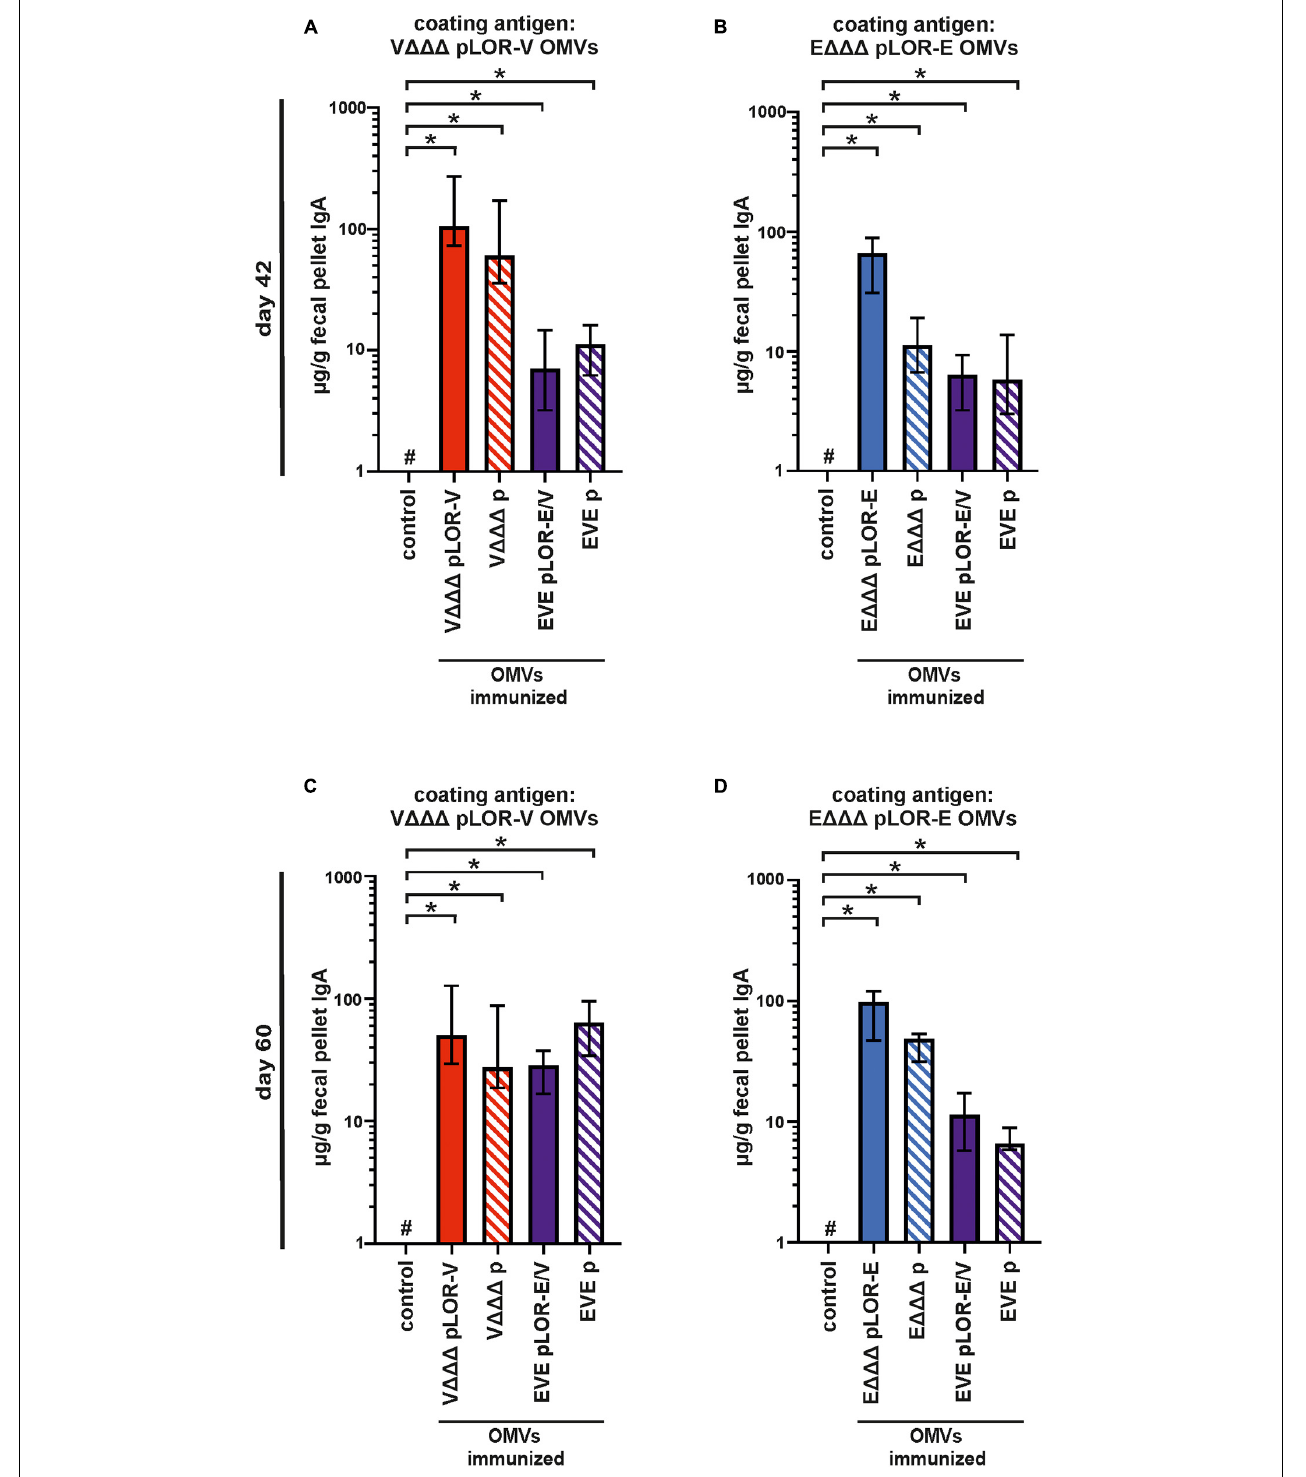
FIGURE 6 | Mucosal immune responses induced in OMV-immunized mice. Shown are median IgA titers to OMVs derived from V (cid:49)(cid:49)(cid:49) pLOR-V (A,C) and E (cid:49)(cid:49)(cid:49) pLOR-E (B,D) extracted from fecal pellets collected at day 42 (A,B) or day 60 (C,D) from the respective immunization groups as indicated ( n = 7 for each group). The error bars indicate the interquartile range of each data set and the hash key that the result of the data set was below the limit of detection (1 µ g/g). Significant differences to the sham-immunized control group are marked by asterisks ( p < 0.05; Kruskal–Wallis test and post hoc Dunn’s multiple comparisons).